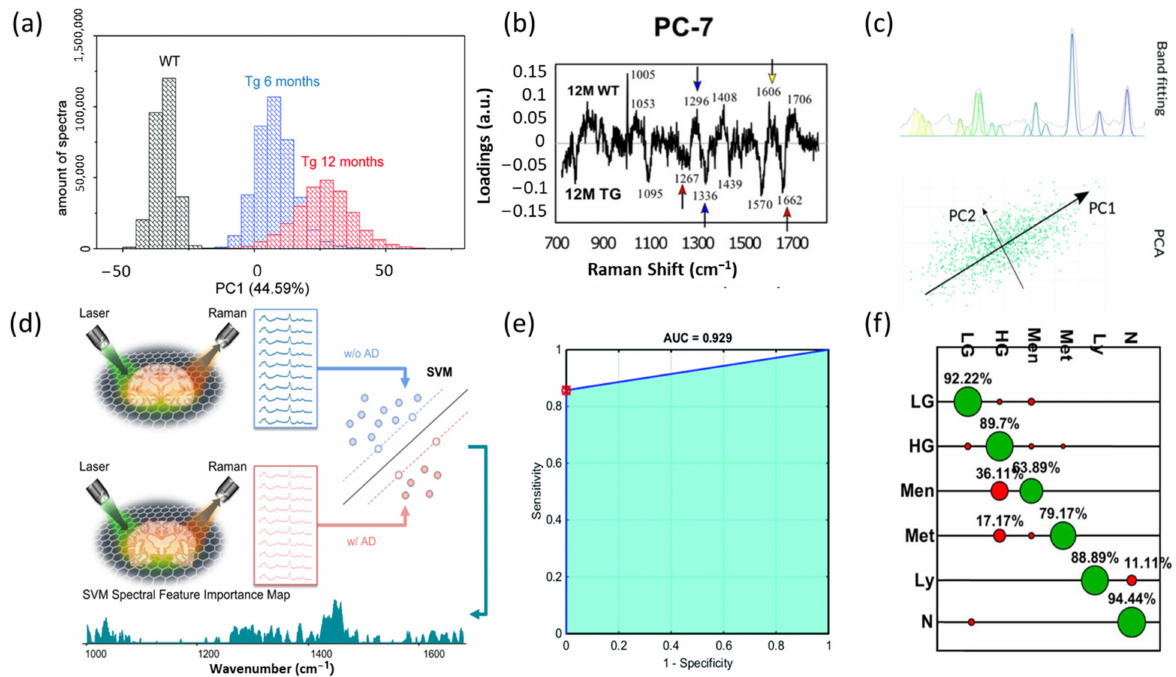
Figure 2. Illustration of applicability of statistical and ML methods on RS in brain clinical applications. ( a ) Histogram showing the differences between groups by PCA of the Raman spectral of brain samples. Twelve-month-old wild-type mice WT (black), six-month-old transgenic mice Tg6 (blue), and twelve-month-old transgenic mice Tg12 (red). Adapted with permission from Reference [19] © 2021 The Royal Society of Chemistry. ( b ) Visualization of the loadings of PC7. Positive side wild-type rat (WT) and negative side transgenic rat (TG) brain samples. Adapted with permission from Reference [20] © 2021 Frontiers. ( c ) Raman spectra were processed by both band fitting and PCA with 50 principal components before being fed into classifiers. Adapted with permission from Reference [22] © 2019 The Royal Society of Chemistry. ( d ) Workflow of Raman signals’ data collection, preprocessing, and ML classification and interpretation to differentiate AD/non-AD Raman spectra of brain samples. Adapted with permission from Reference [26] © 2022 American Chemical Society.